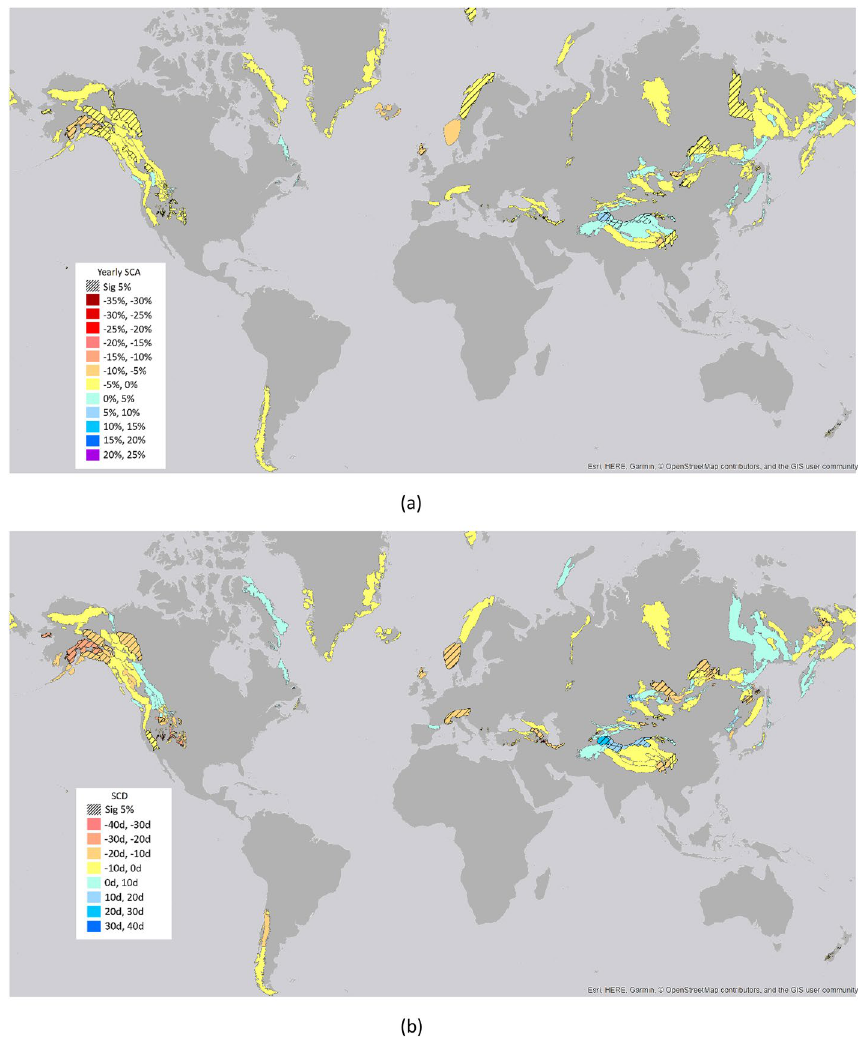
Figure 1. Global trends over 1982–2020 for ( a ) SCA and ( b ) SCD parameters. The figure shows the results of the Mann–Kendall statistics over mountain areas. The underlined areas show significant trends at 5% level